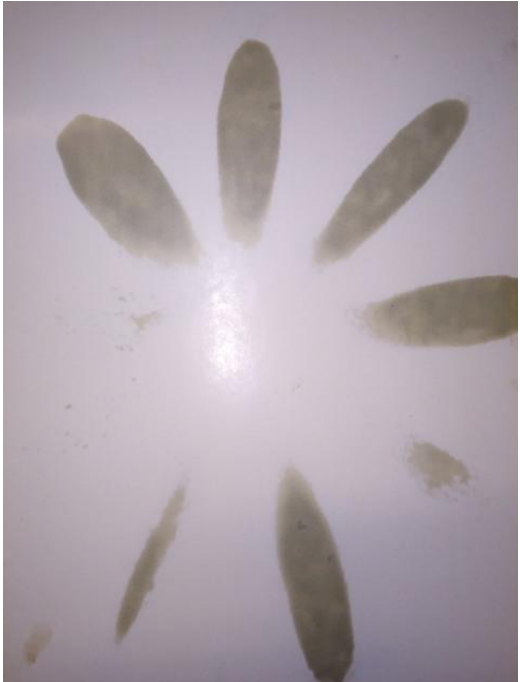
Figure 4. Fuel stream sprayed by a coked injector nozzle (naturally coked obtained from the engine department of the repair shipyard). Three out of nine ports are clogged.